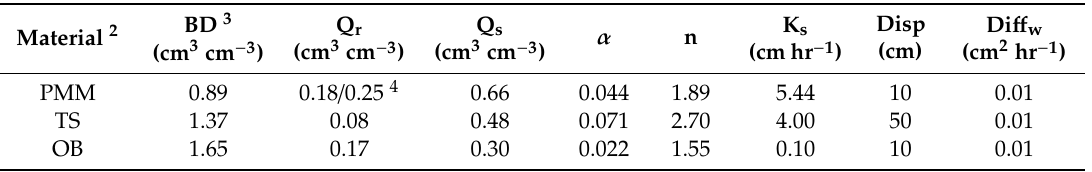
Table 4. Hydraulic and solute transport parameters 1 for the reclamation materials used in the HYDRUS-1D model.